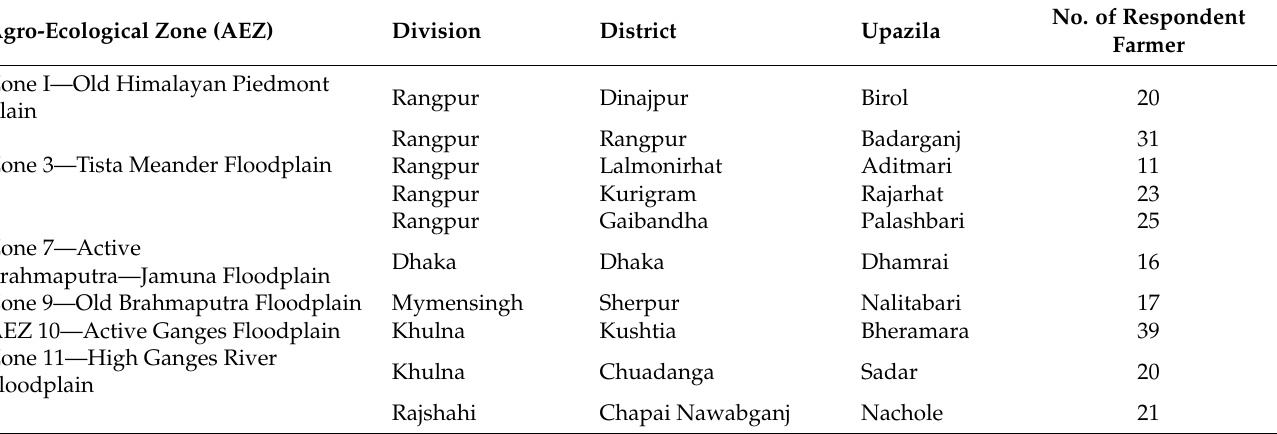
Table 1. Study locations and sample sizes for farmers’ perception study.